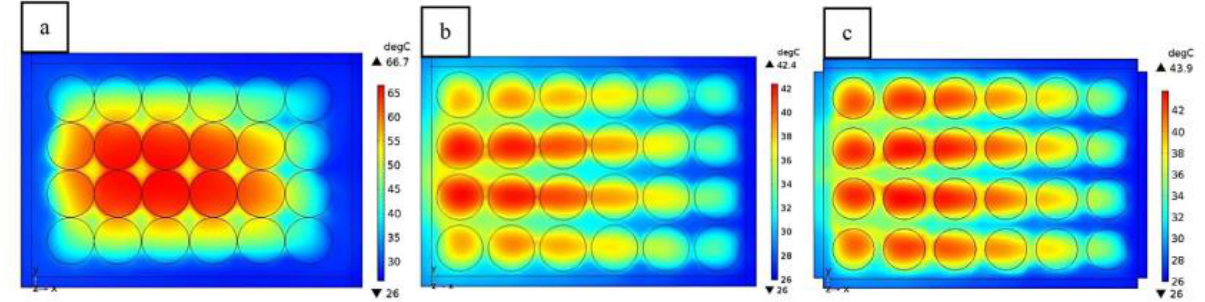
Figure 17. Simulation of temperature distribution in an air-cooled system for different cell spacings at a discharge rate of 1.5 C for an inlet flow of 2 m/s, and an initial temperature of 26 °C [98] . Cell spacings for the simulation: ( a ) 0, ( b ) 2, and ( c ) 4 mm. Reprinted with permission from [98] . Copy- right 2020 Elsevier.